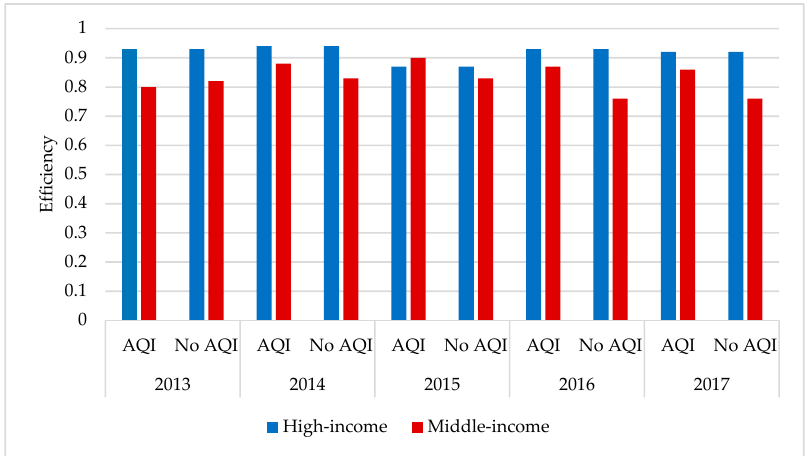
Figure 4. Table technology gap from 2013-2017 between the high- and middle-income